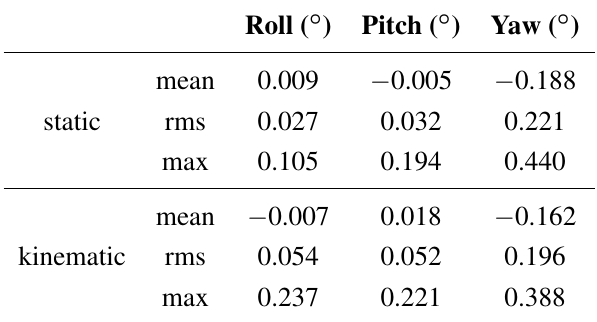
Table 3. Results of an experiment with the test